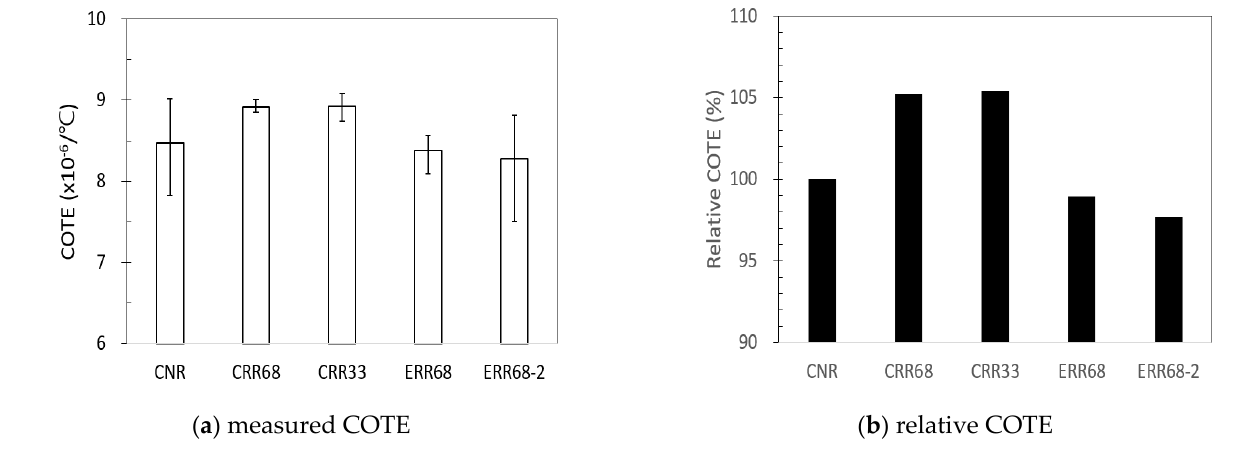
Figure 5. COTE and relative values in test series 1.